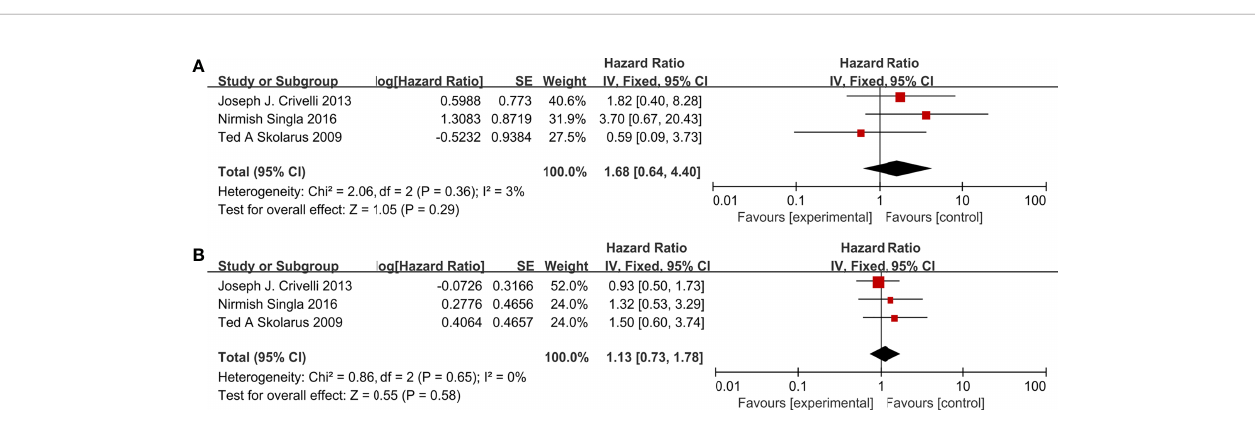
FIGURE 6 | Forest plot for cardiovascular drugs ’ effect on CSS and OS: (A) CSS, (B)